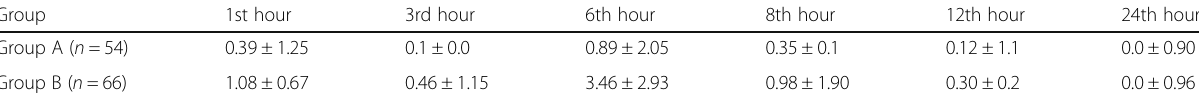
Table 2 Pain score in different time interval after cardiac surgery (data are presented as mean and standard deviation) Group